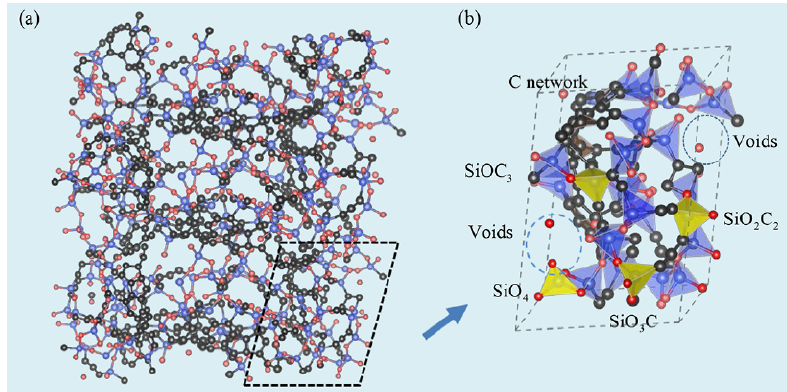
Fig. 20 Atomic model of SiOC. (a) Overview of the supercell; (b) unit cell shows a series of vertex-sharing tetrahedra (blue atoms: silicon atoms; red atoms: oxygen atoms; gray atoms: segregated carbon phase which forms the backbone of the network; blue dotted circles represent the nanovoids percolated in the lattice which contribute to the low density of the SiOC molecule). Reproduced with permission from Ref. [459], © American Chemical Society